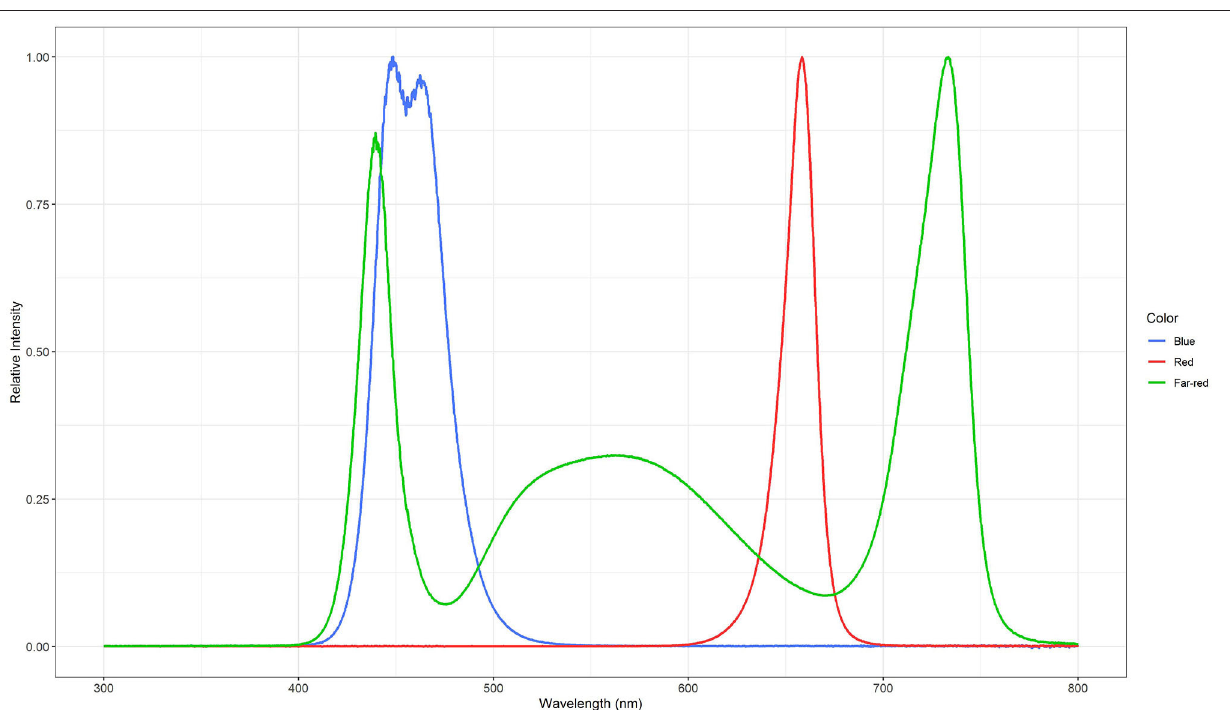
Frontiers in Plant Science |